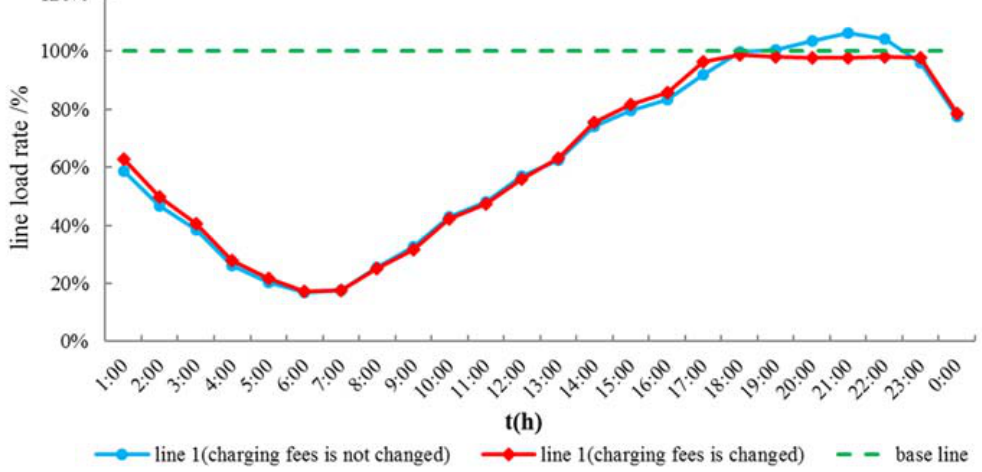
Figure 5. Line load rate of line 1 before and after adjustment for charging fees.